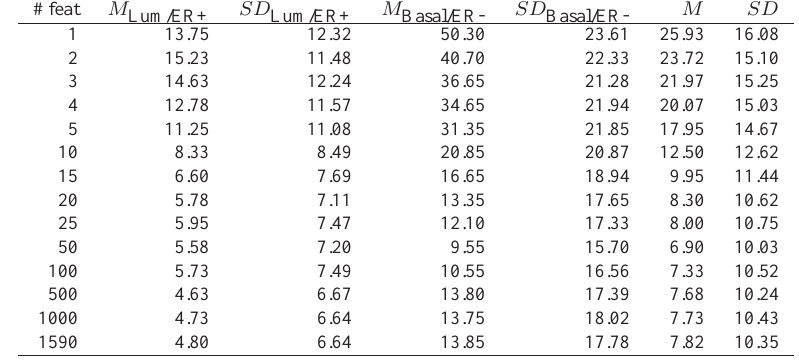
Table 2: Predictive errors ( M ) with standard deviation ( SD ) on the copy number data (BAC) for the Lum/ER+ and Basal/ER- task (separately on the two classes and for all data), after shaving two